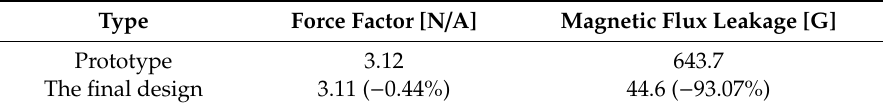
Figure 14. Magnetic flux line: ( a ) second design; ( b ) final design. Table 6. Comparison of analysis results between the prototype and second design.